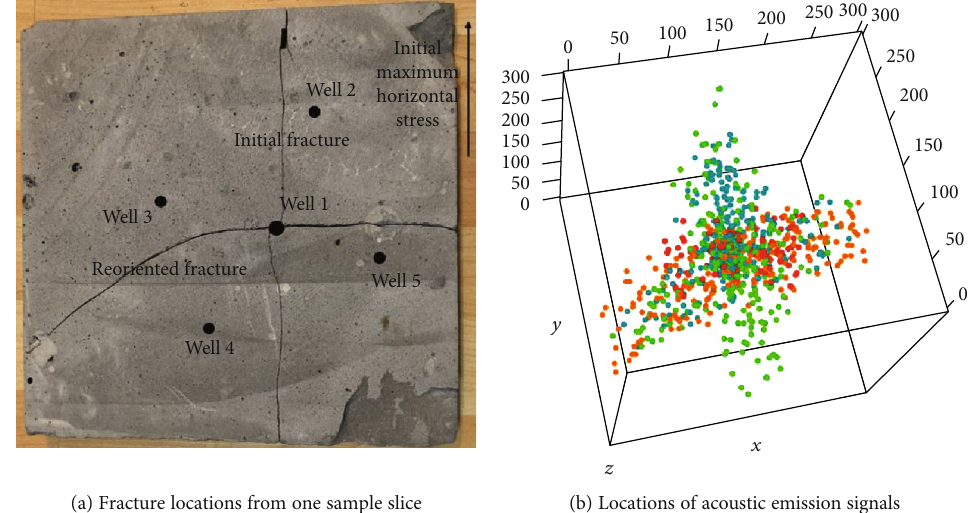
Figure 5: Image of induced orthogonal fractures from a horizontal slice of the sample ( 30 cm × 30cm ) and 3D scatter diagram of acoustic emission locations for sample 1 ( 30cm × 30 cm × 30cm